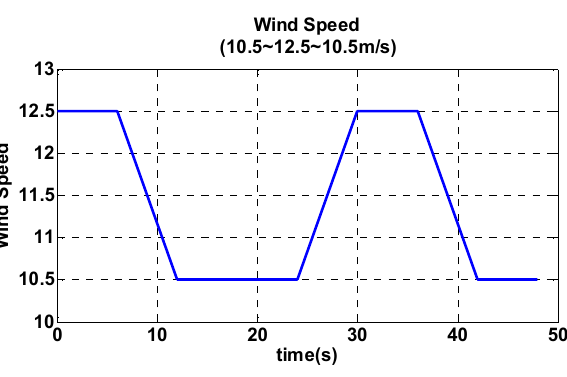
Figure 9. Step input changes for wind speeds from 10.5 to 12.5 m/s.